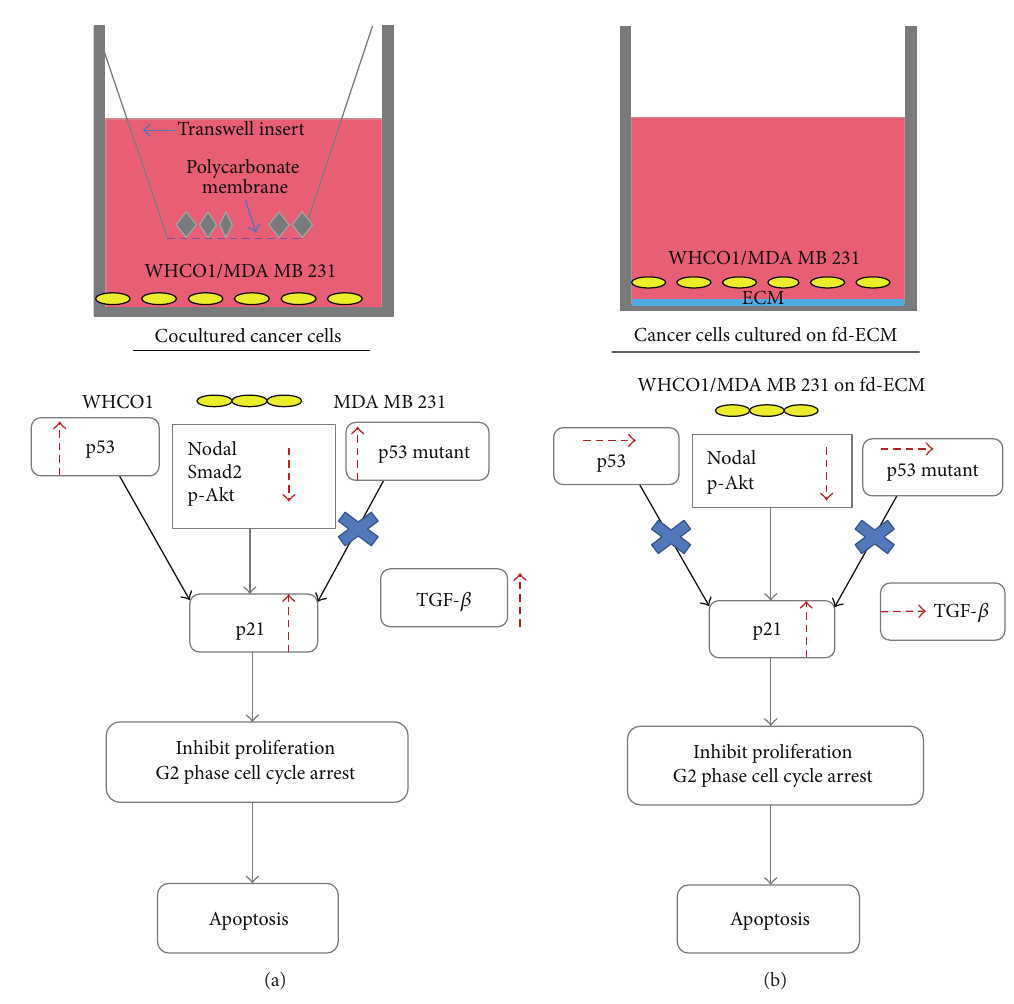
Figure 9: Summary of MSCs- and fd-ECM-mediated inhibition of cancer cell proliferation and G2 phase cell cycle arrest leading to apoptosis. (a) In the short term, the downregulation of tumorigenic pathways such as Akt and Nodal results in an upregulation of p21. p21 inhibits cancer cell proliferation and induces G2 phase cell cycle arrest leading to apoptosis. (b) fd-ECM-mediated inhibition of cancer cell proliferation and G2 phase cell cycle arrest occur via the same mechanism as for MSCs with the exception that there is no p53 and TGF- 𝛽